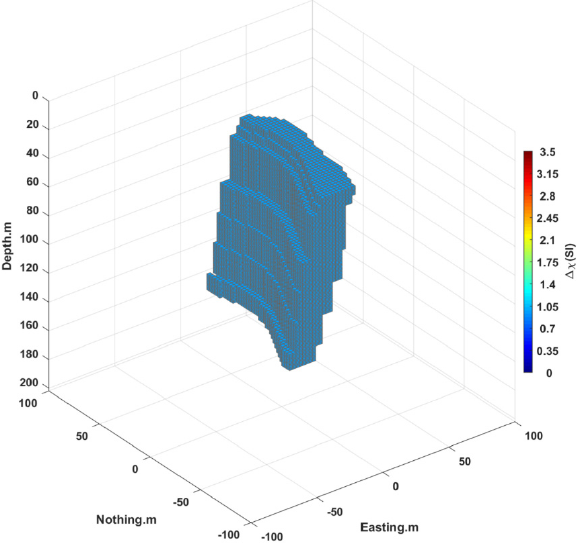
Figure 18. Side view of the 3D inversion model of magnetite sillimanite . In the measurement area, there is an outcrop with line number 60 mN with its front end adjacent to the outcrop, as shown in Figure 16; in the range of 35 m~45 m on the X- axis, there is a semicircular anomaly with interference information, but it does not affect the prediction results because the constructed real measurement model is empty in the outcrop area, which indicates that, through the construction of the model area, the CNN can realize the designation of the prediction area and suppress the noise interference in the non-prediction area to realize its function, similar to the local fixed-point focus. 5. Conclusions By training on a large number of image samples generated by a synthetic model, a CNN can be used to extract magnetic parameters, synthesize all magnetic parameters and then achieve an inversion model of MGT data. In this work, we develop a CNN-based 3D inversion method for MGT data. We use randomly generated image samples of each in- dependent component of the MGT for the classification and identification of geometric shape information and physical parameters of magnetic gradient detection data of mag- netic target bodies. We also investigate a method of identifying the geometric shape and depth first and then further identifying the physical property parameters, and this step- wise identification method can suppress the influence of uncertainties and improve the recognition rate. We validate our optimized CNN inversion network by two synthetic models and shear model comparison tests, and prove that the geometric shape and mag- netic parameter information of a magnetic target body can be effectively recognized by the trained CNN. In this study, it is found that the discontinuity of CNN classification labels can cause the illusion of large actual errors and falsely high prediction accuracy. The MGT data span a large magnitude and are severely polarized. With a uniform color scale display of the sample set, samples with weak MGT signals are blurred during imag- ing and fail to present their overall features, which affects the image imaging quality and leads to a lower recognition rate or even failure to converge in training. It is necessary to reduce the spacing of adjacent label values, refine the range of label values or resort to other auxiliary methods in order to improve the recognition rate.